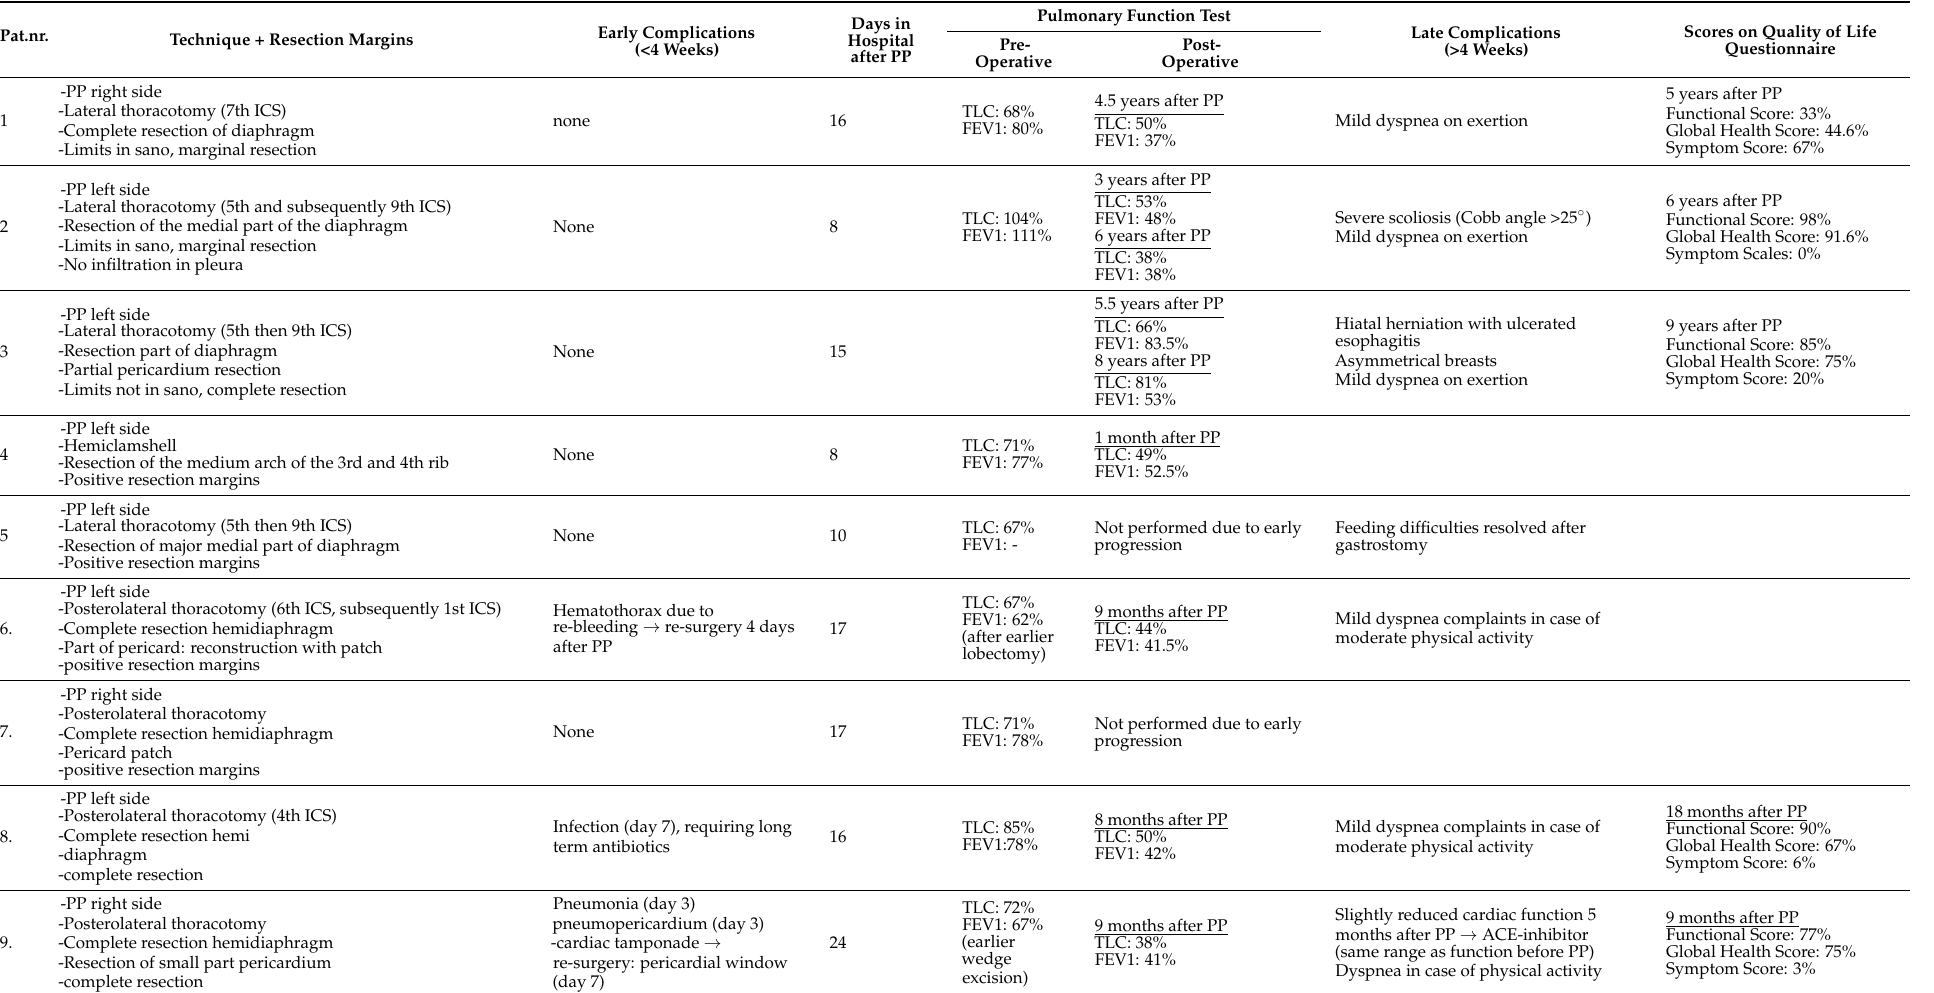
Table 2. Information regarding the total pleuropneumonectomy (PP), complications, hospitalization days, lung function and scores on the quality of life questionnaire of individual patients ICS= intercostal space, TLC: total lung capacity, FEV1: forced expiratory volume in 1 s.